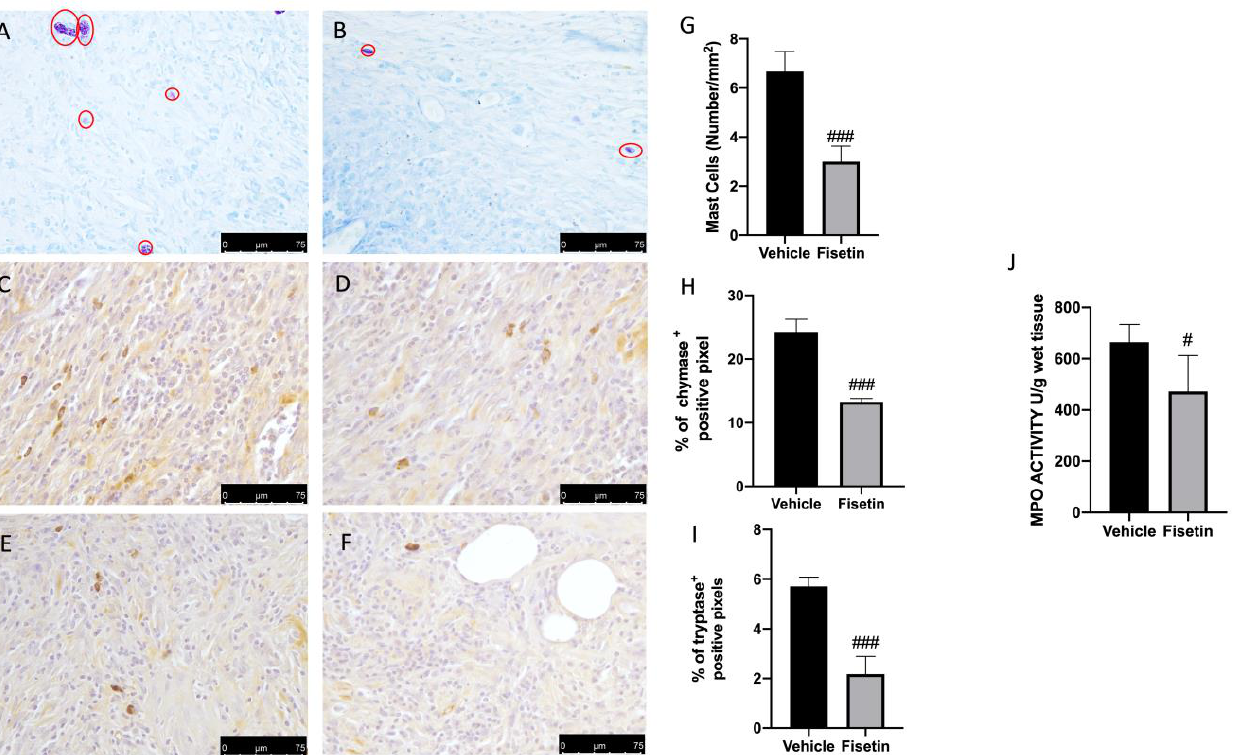
Figure 2. Fisetin administration on MCs activation: Blue toluidine staining to detect MCs (red circle) in endometriosis + vehicle ( A ), endometriosis + fisetin ( B ). Immunohistochemistry for chymase and tryptase in endometriosis + vehicle ( C , D ), in endometriosis + fisetin ( E , F ). Number of MC/mm 2 ( G ). The results are expressed as % of positive pixels ( H , I ). Figures are representative of at least three independent experiments. MPO activity ( J ). Values are means ± SEM of 6 animals for each group. Scale bar: 75 μm. ### p < 0.001 vs. vehicle # p < 0.05 vs. vehicle.